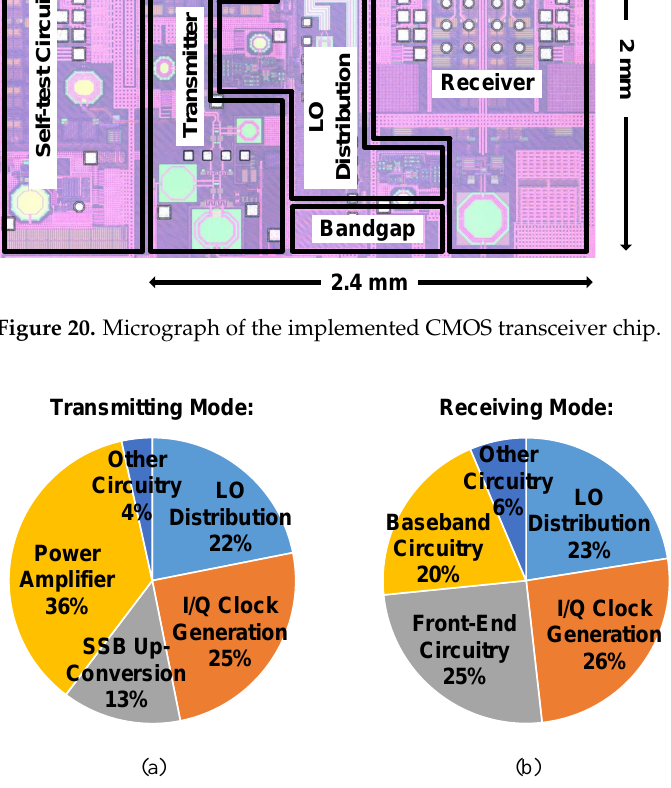
Figure 21. Power consumption of the CMOS transceiver operated in ( a ) transmitting mode and ( b ) receiving